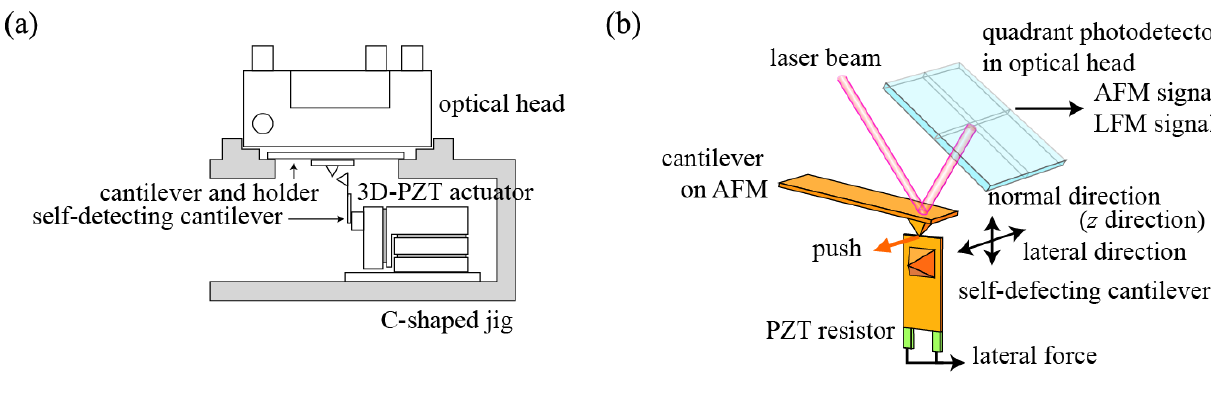
Figure 1. ( a ) Schematic of experimental apparatus. ( b ) Cantilever on AFM and self-detecting cantilever arranged perpendicular to each